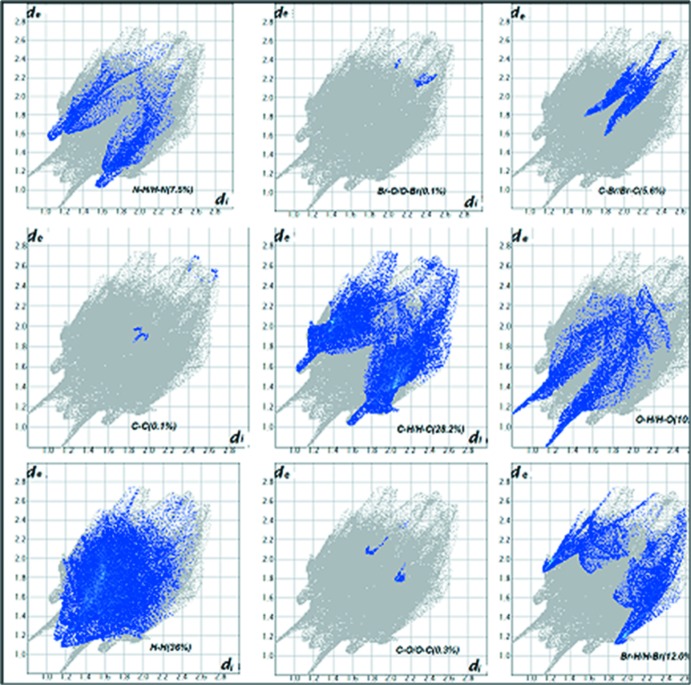
Two-dimensional fingerprint plots with the relative contributions of the various inter­actions.